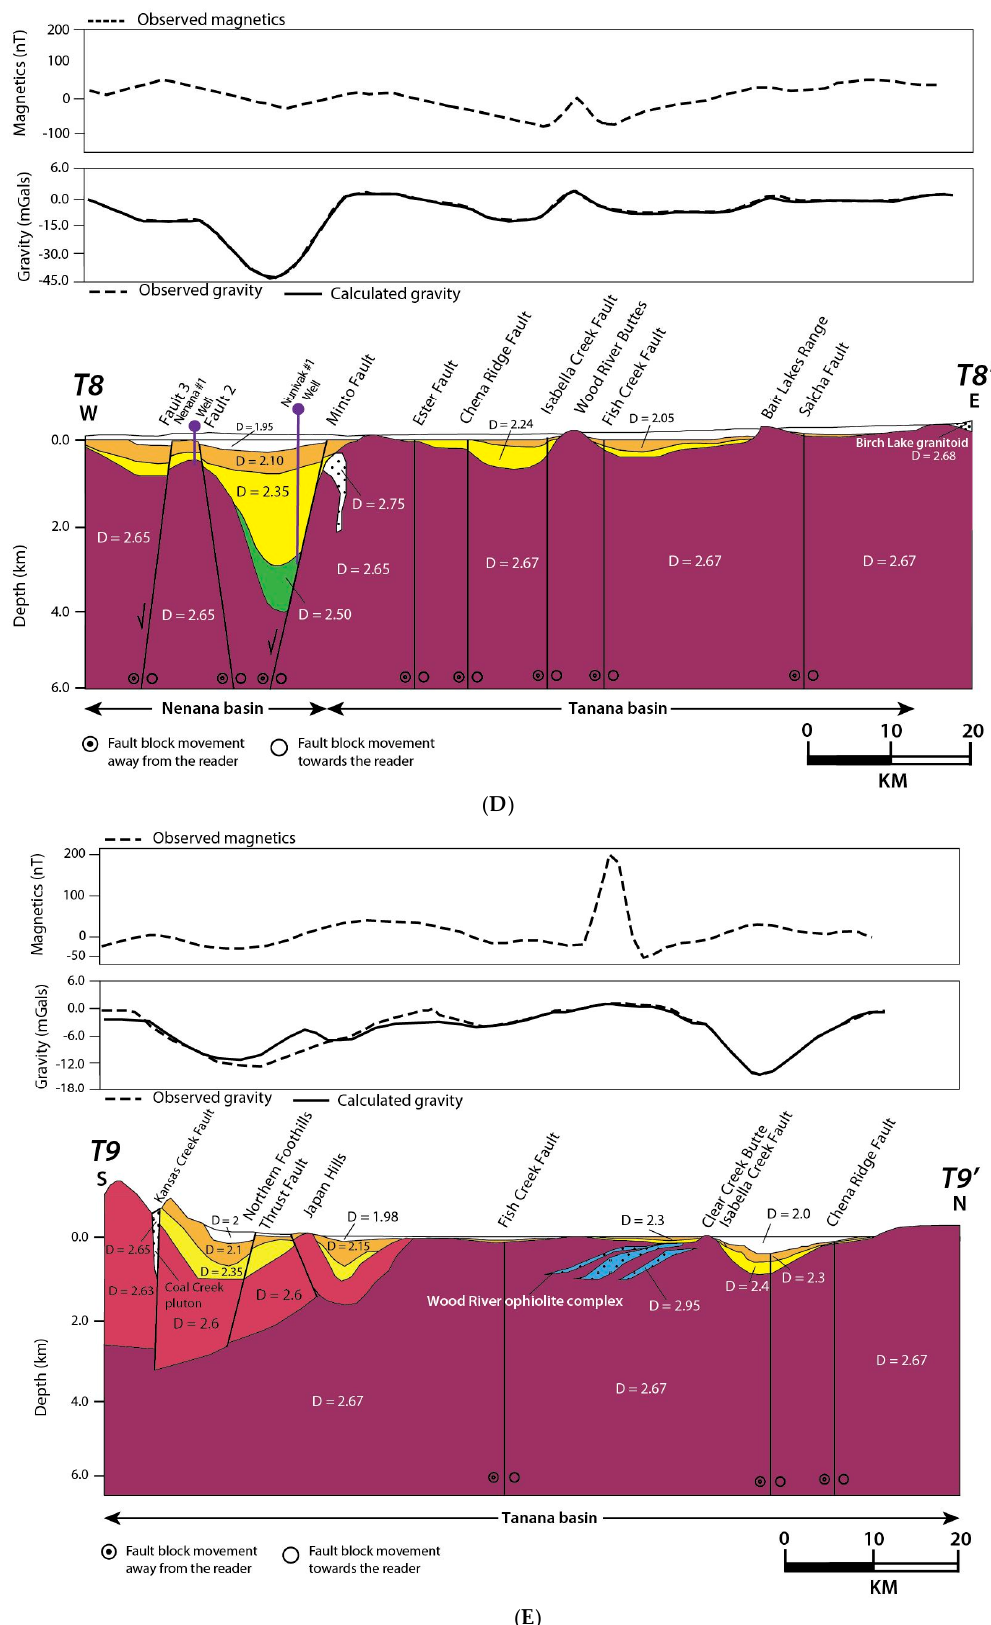
Figure A1. ( A ) Upper crustal model along Profile T1. ( B ) Upper crustal model along Profile T2. ( C ) Upper crustal model along Profile T6. ( D ) Upper crustal model along Profile T8. ( E ) Upper crustal model along Profile T9.